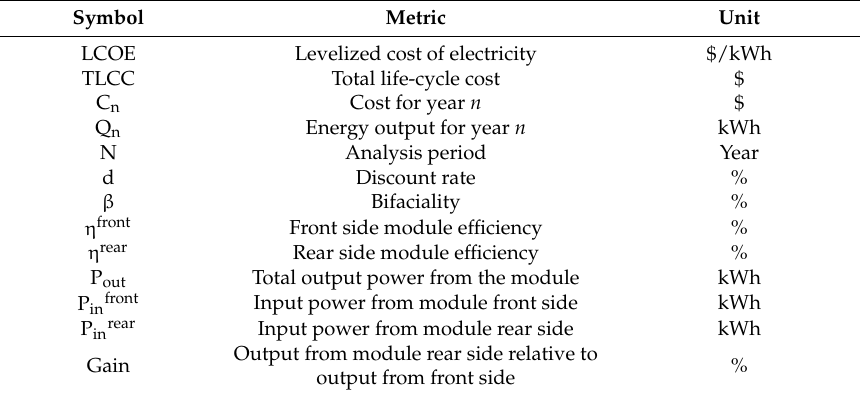
Table A1. Symbol list for equations in this Table 1. Symbol list for equations in this paper.